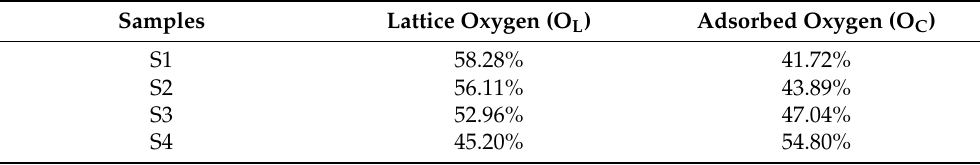
Table 1. The percentage of different components in O 1s for Au@ZnO